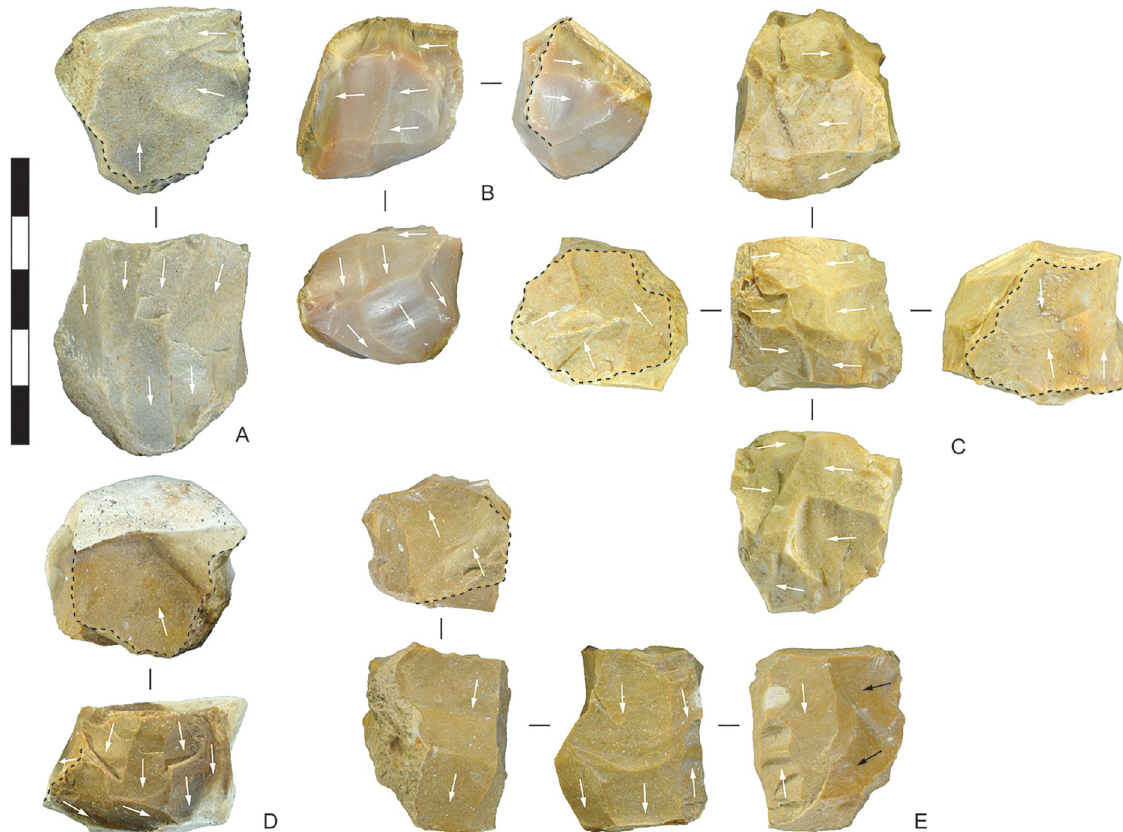
Fig 14. Chert single platform and multiplatform cores, Horizon IV, Saruq al-Hadid. Dotted black lines outline platform surfaces, and arrows show the direction of major flake scars. (A) Core with three flakes removed across the end followed by rotation and striking flakes down the adjacent face using the prior scars as the platform. The reduction surfaces are adjacent to the one platform edge, so this is classified as a single platform core. (B) Core reduced in a similar way to A, but with evidence for two prior rotations and reduction from platforms that no longer exist. The final platform was established on the lateral margin of a prior scar. Only one platform now exists, so this is classified as a single platform core. (C) Core with a ‘cuboidal’ morphology, with bidirectional reduction down the core face from platforms at either end. Two independent platforms exist, so this is classified as a multiplatform core. (D) Core reduced in a similar way to A, but from a platform surface composed of a single large negative scar. The core was rotated and flakes were struck from the lateral margin of a prior scar, creating a second independent platform. The core is classified as multiplatform. (E) Core reduced bidirectionally from a multi-scar platform at one end (similar to A) and a cortical platform at the opposite end. The core has two independent platforms and is classified as multiplatform. The blank was a core recycled from an older lithic scatter; the black arrows indicate scars from the earlier reduction. All of these cores have platforms oriented at close to 90 degrees to the core face, and platforms on A-D are crushed, perhaps indicating anvil support. From